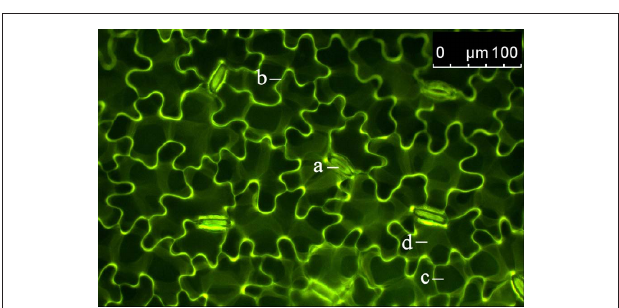
Figure 3 | Distribution of the dextran-conjugated dye Oregon green 488 at 1.5 h after the loading event. Adaxial leaf face. Overlay of pseudo-green fluorescence image at ex 495 nm and pseudo-red fluorescence image at ex 440 nm. Images were collected at the leaf edges adjacent to the area that was loaded with the dye. The detection of dye emission signals at an area that was not loaded with the dye itself indicates that the dye is mobile within the leaf apoplast. This allows apoplastic pH to be measured in areas of the leaf apoplast not affected by the dye loading. a, stomatal apparatus; b, epidermal apoplast; c, palisade cell (dark structure; no dye signal); d, apoplast surrounding palisade mesophyll.